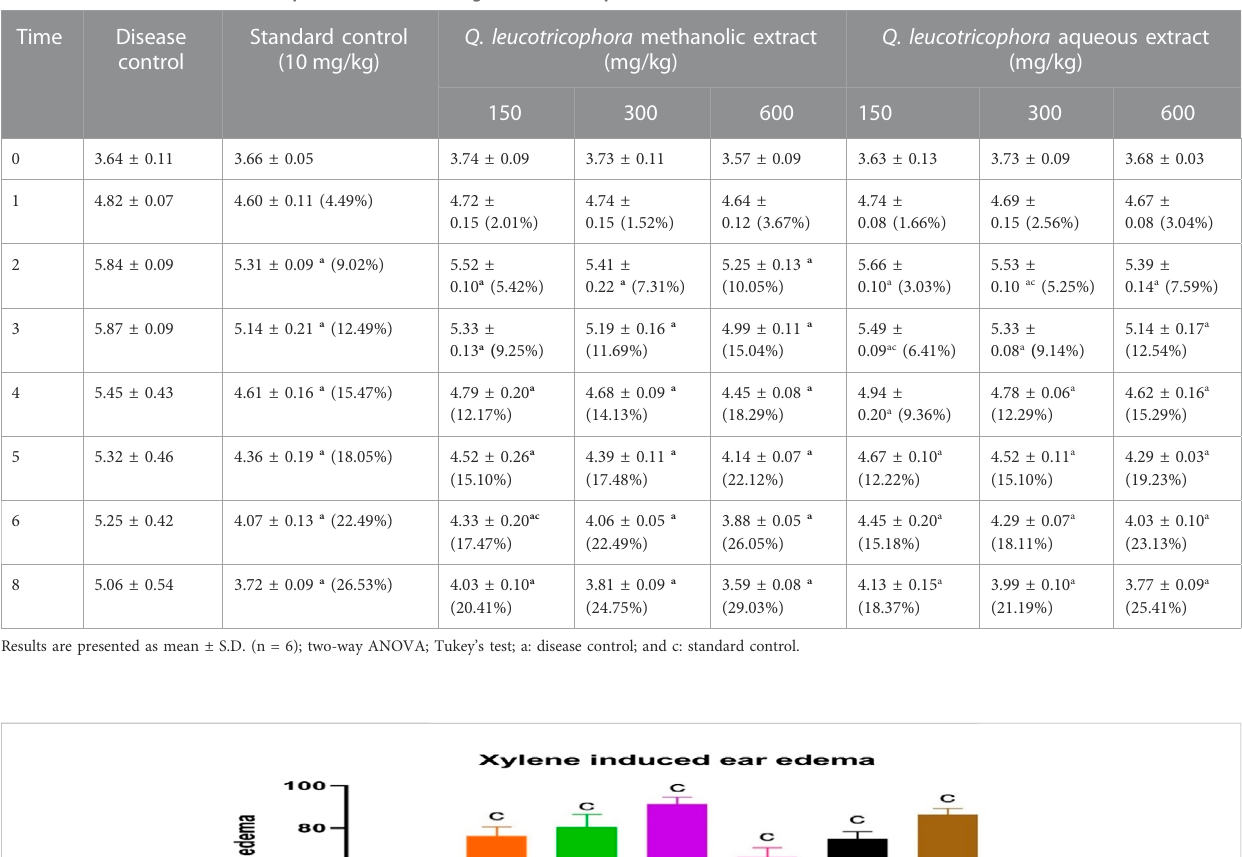
TABLE 2 Effect of Quercus leucotrichophora extracts in carrageenan-induced paw edema in rats as a function of time and administered